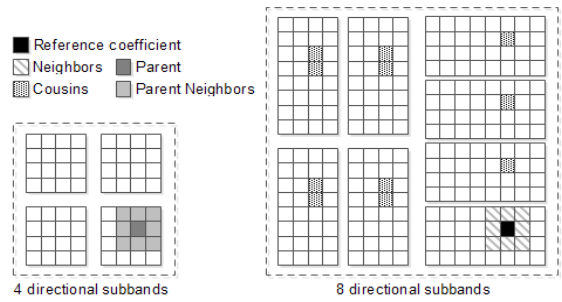
Figure 3. The relationship among Contourlet